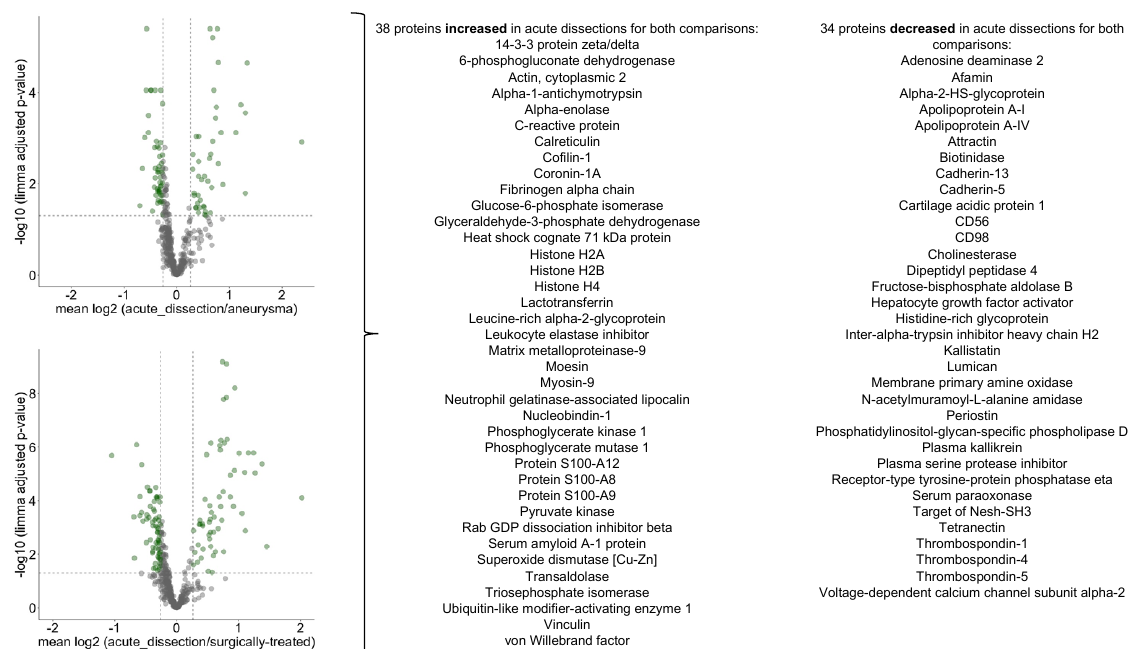
disease severity; Table S4: limma statistics comparing acute dissections to aneurysms; Table S5: limma statistics comparing acute dissections to surgically treated